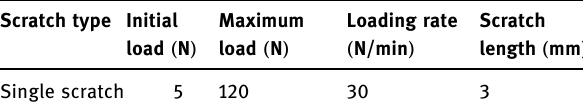
Table 2: Experiment parameters for scratch test Scratch type Initial